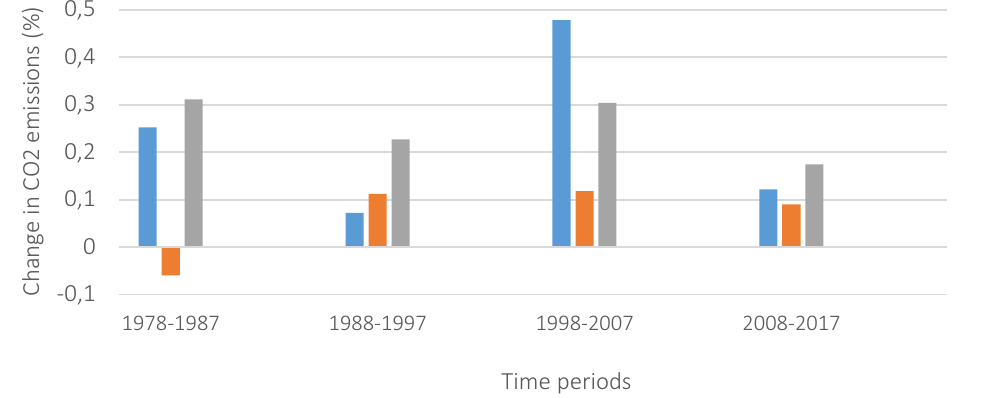
Figure 2. Changes in released CO